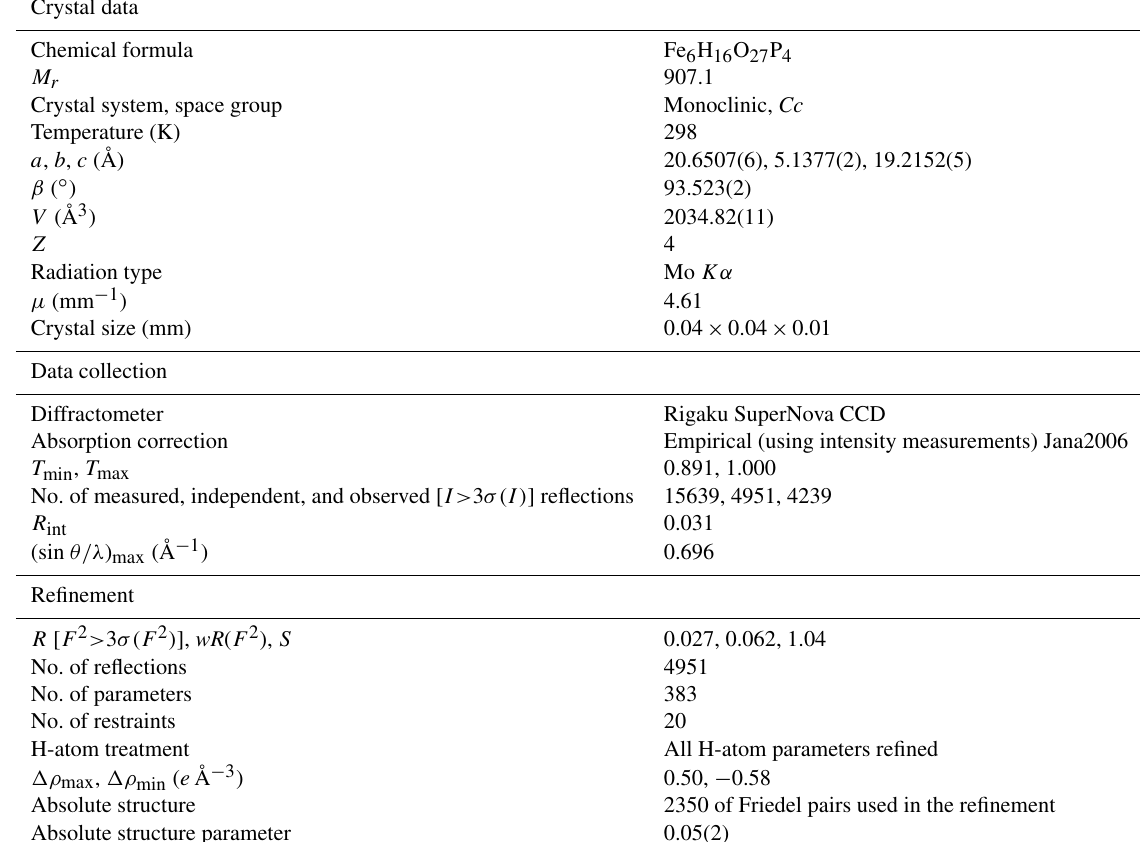
Table 5. Details for the data collection and refinement of the structure of beraunite. Crystal